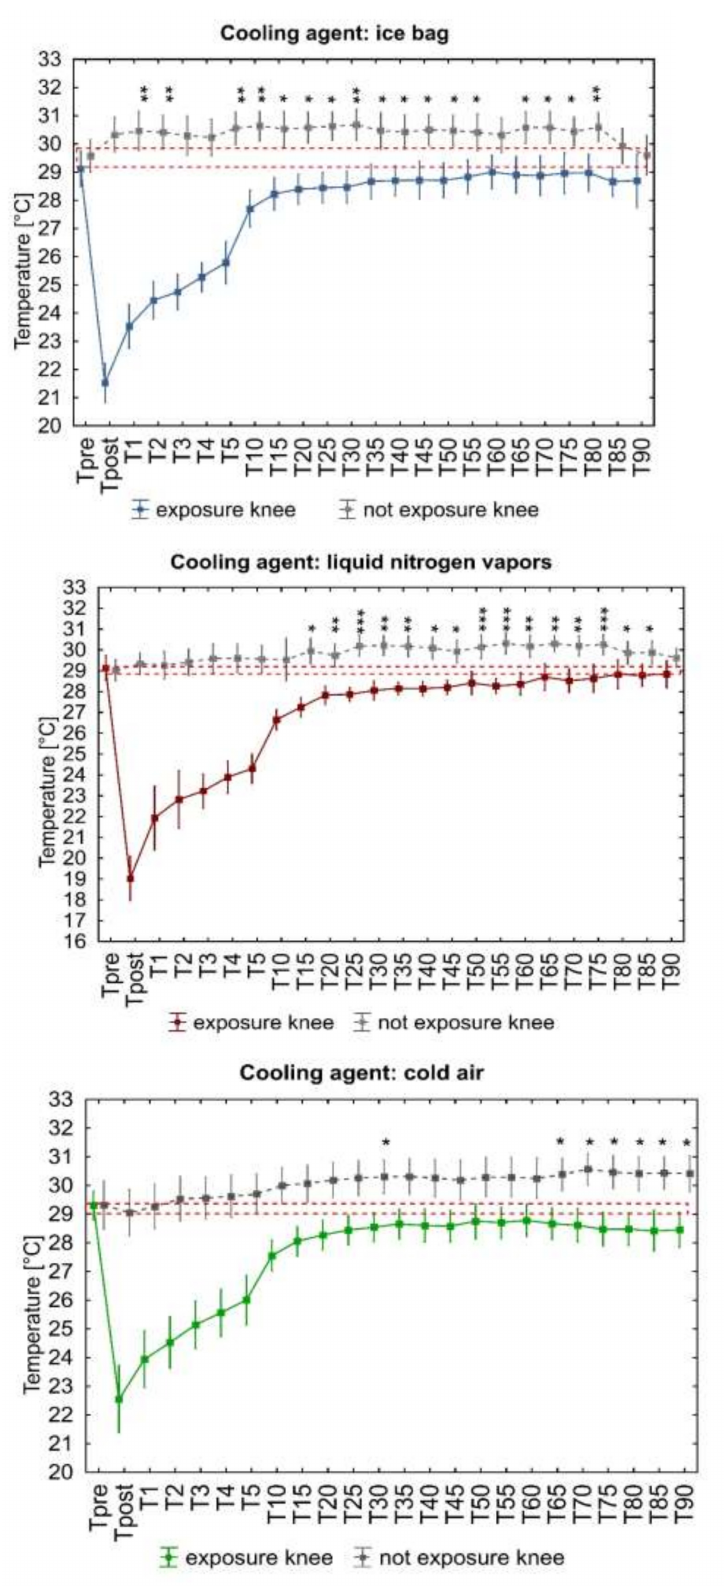
Figure 7. Analysis of ROI NE and ROI E surface temperature changes during 90 min of observation. Legend: Student t-test probability level between pre-exposure and post-exposure ROI NE temperature (from T post to T 90 ): * p < 0.05, ** p = 0.001, *** p = 0.001. Data are expressed as mean with standard deviation; the dashed orange line represents the level of the mean output temperature for both ROI NE